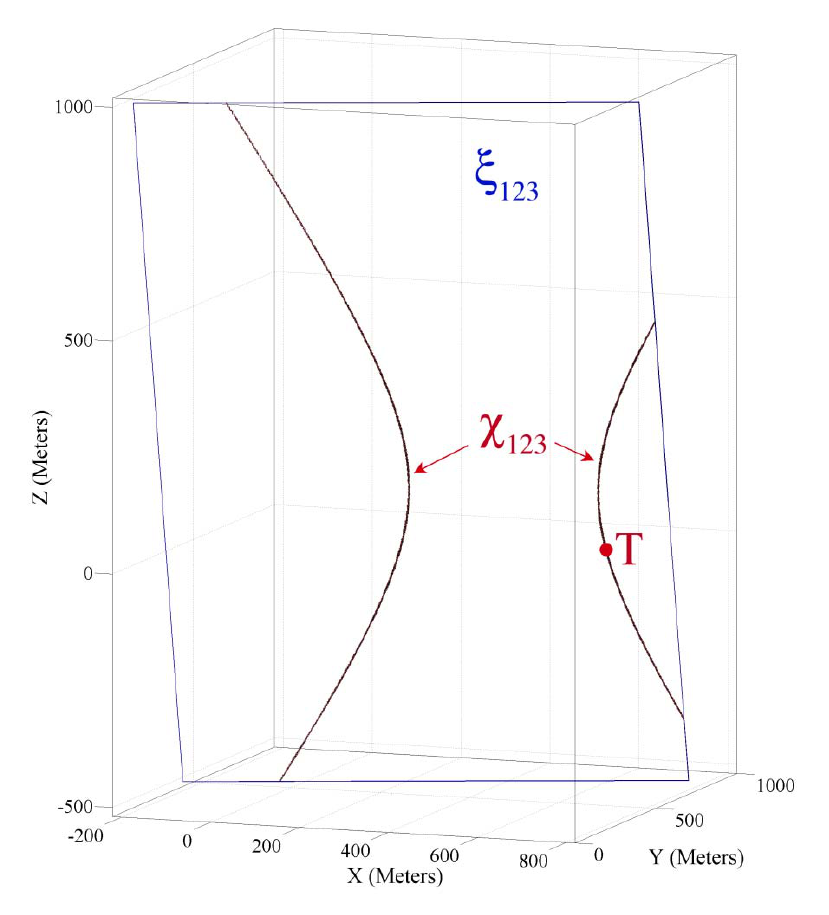
Figure 6. The axis plane of sensor nodes 1, 2 and 3, alongside their intersection curve, in the range of [ − 4,4]